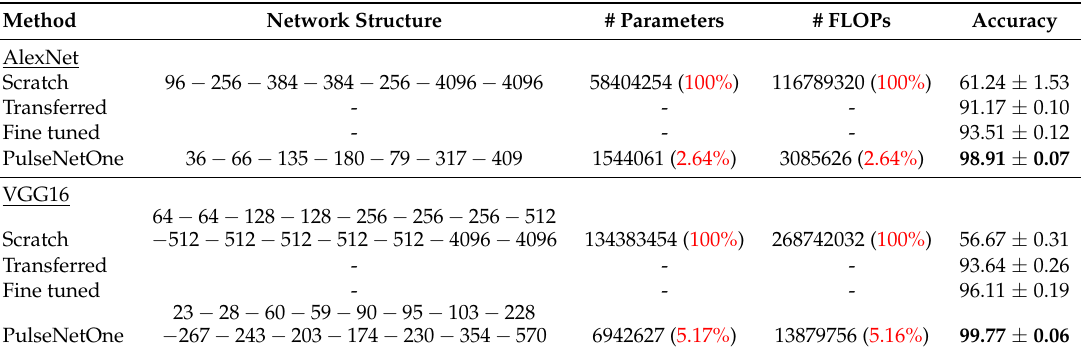
Figure 1. Comparison of layers between original and pruned version of both AlexNet and VGG16 on the AID dataset. Table 2. Overall accuracies and standard deviations (%) of different types of CNNs methods along with PulseNetOne on the AID dataset. The entries in bold show the method with the best classification for the network, while the percentage of the original network is highlighted in